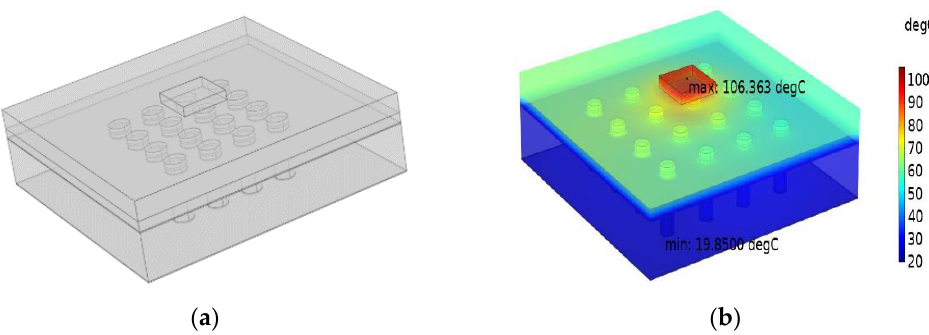
Figure 4. TSV array model and simulation result diagram: ( a ) TSV array model diagram; ( b ) TSV Array Peak Temperature Simulation Results.